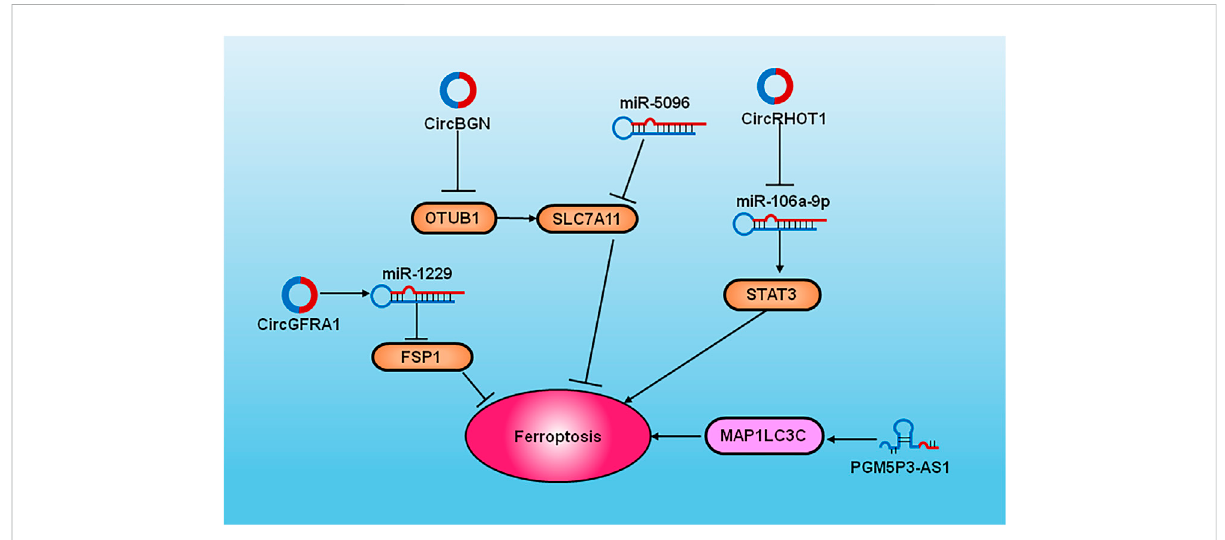
FIGURE 3 Thediagramofcell signaling pathwaysofncRNAs andferroptosisinbreastcancer. Theoverexpression ofSLC7A11inhibits miR-5096 to induce ferroptosis. PGM5P3-AS1 regulates MAP1LC3C to induce the occurrence of ferroptosis. CircRHOT1 inhibits ferroptosis by targeting the miR-106a- 5p via STAT3. CircGFRA1 sponge with miR-1228 and improves FSP1 expression. CircBGN binds to OTUB1 and SLC7A1 and inhibits